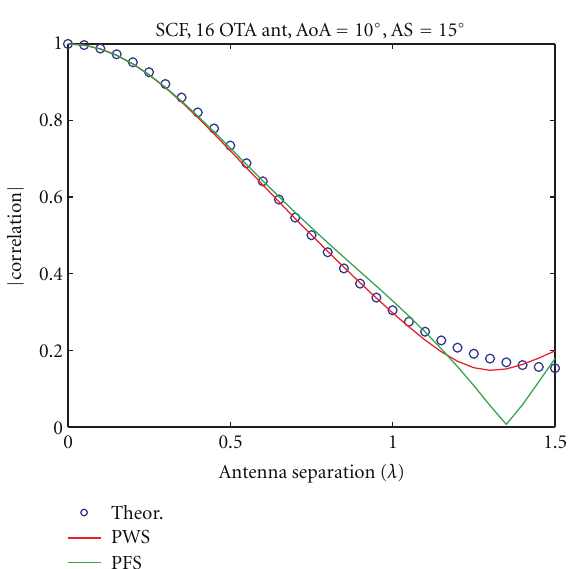
SCF, 16 OTA ant, AoA = 10 ◦ , AS = 15 ◦